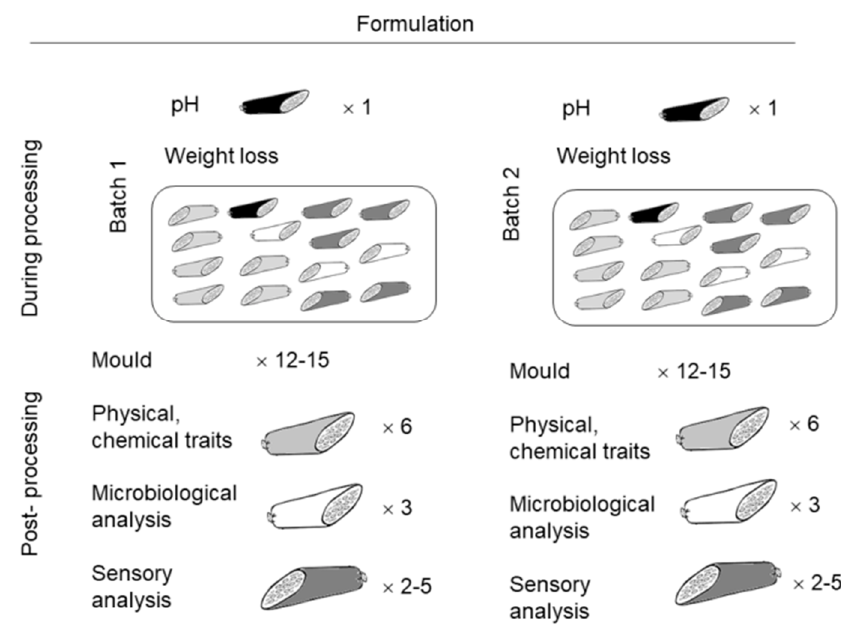
Figure 1. Number of sausages used for specific analyses .